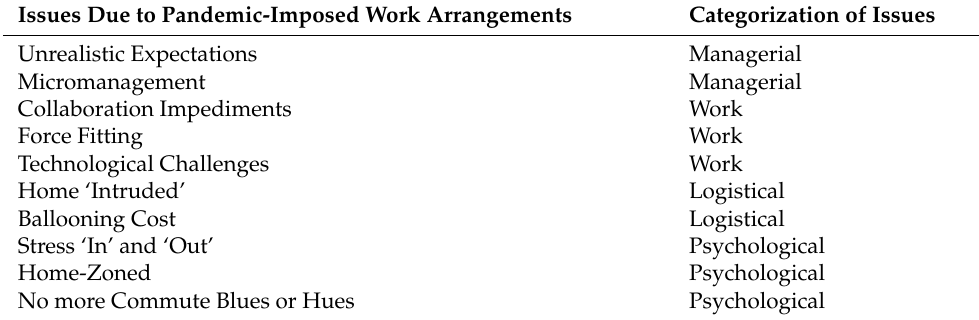
Table 2. Issues due to pandemic-imposed work